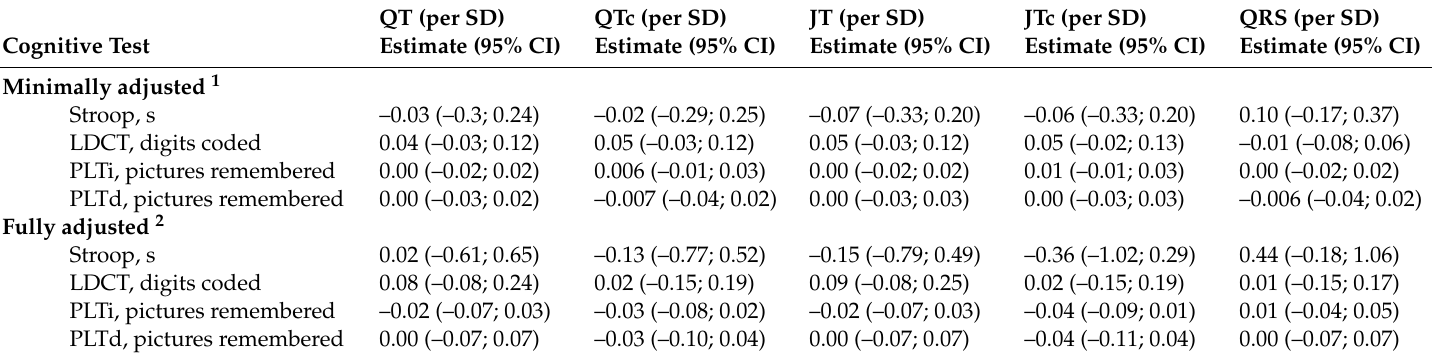
Table 3. Longitudinal associations between measures of ventricular de- and repolarization and cognitive function.